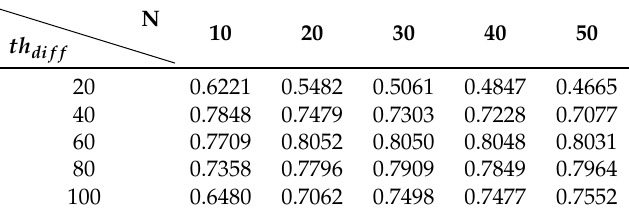
Table 3. Average FM with different th dif f and N .